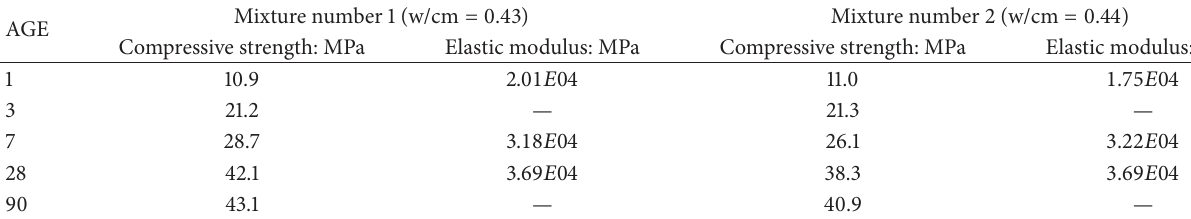
Table 3: Compressive strength and elastic modulus of Mixture number 1 and Mixture number 2.